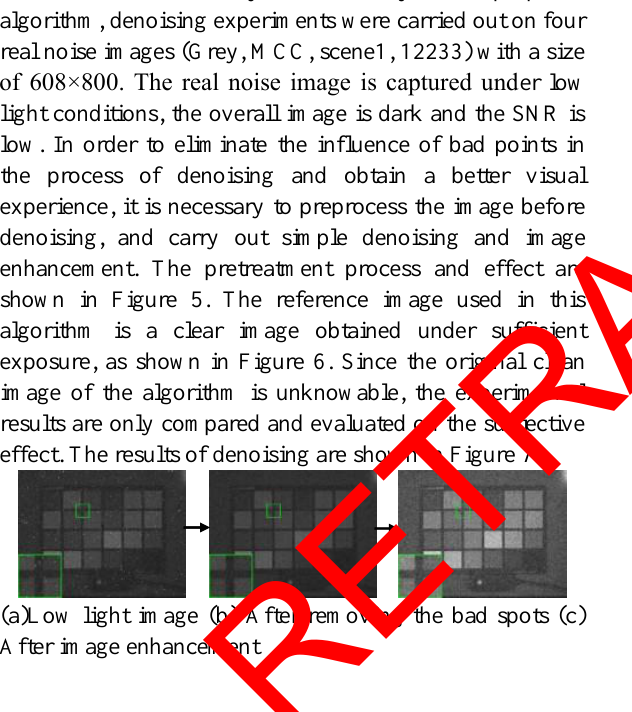
Figure 7. Real strong noise image denoising